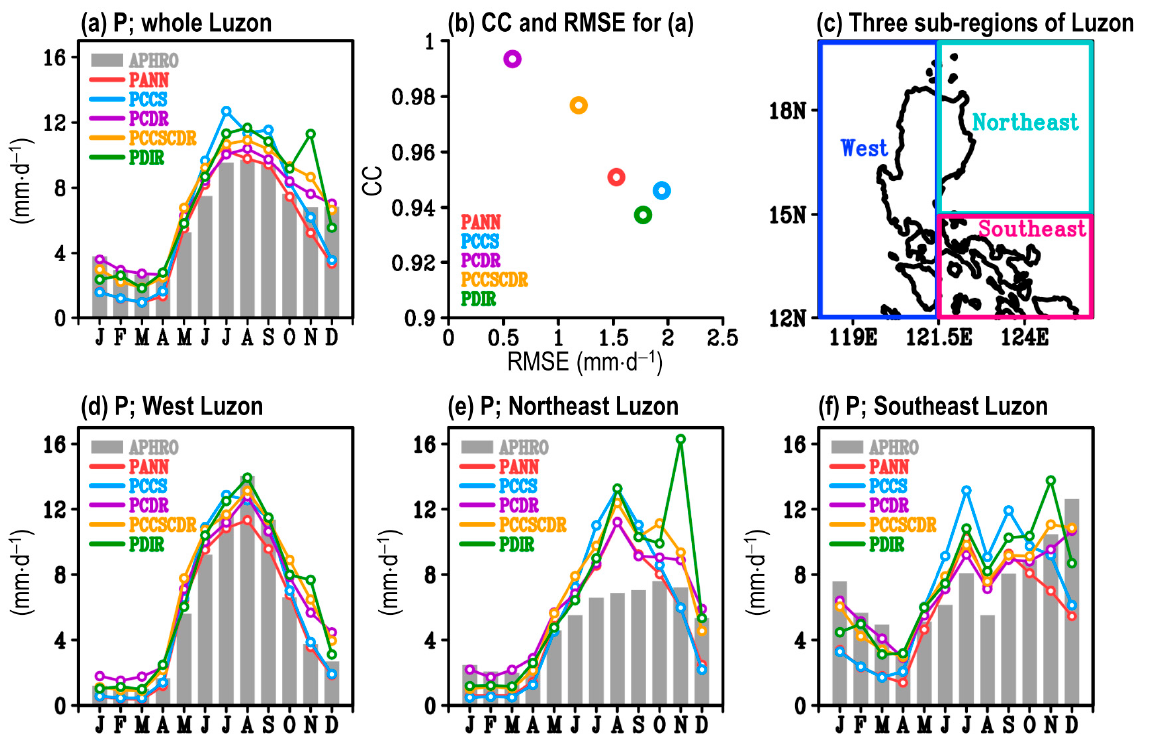
Figure 4. Monthly mean precipitation (denote as P) of the APHRO (bar) and the five products of the PERSIANN-series (including PANN, PCCS, PCDR, PCCSCDR, and PDIR) (lines) in the entire Luzon region as averaged from 2003–2015: ( b ) the correlation coefficient (hereinafter CC) and the root mean square error (hereinafter RMSE) that were calculated between the time series of APHRO and each product of PERSIANN-series in ( a ); ( c ) three inland sub-regions of Luzon: west, northeast, and southeast; ( d ) As in ( a ), but for west Luzon ( c ); ( e ) as in ( a ), but for northeast Luzon ( c ); and ( f ) as in ( a ), but for southeast Luzon ( c ). Table 3. Correlation coefficient (CC) and root mean square error (RMSE; the unit is mm · d − 1 ), for comparison between the time series of ground-based observation (APHRO) and the five products of Figure 4. The product possessing highest value of RMSE or lowest value of CC is marked by *. PANN PCCS